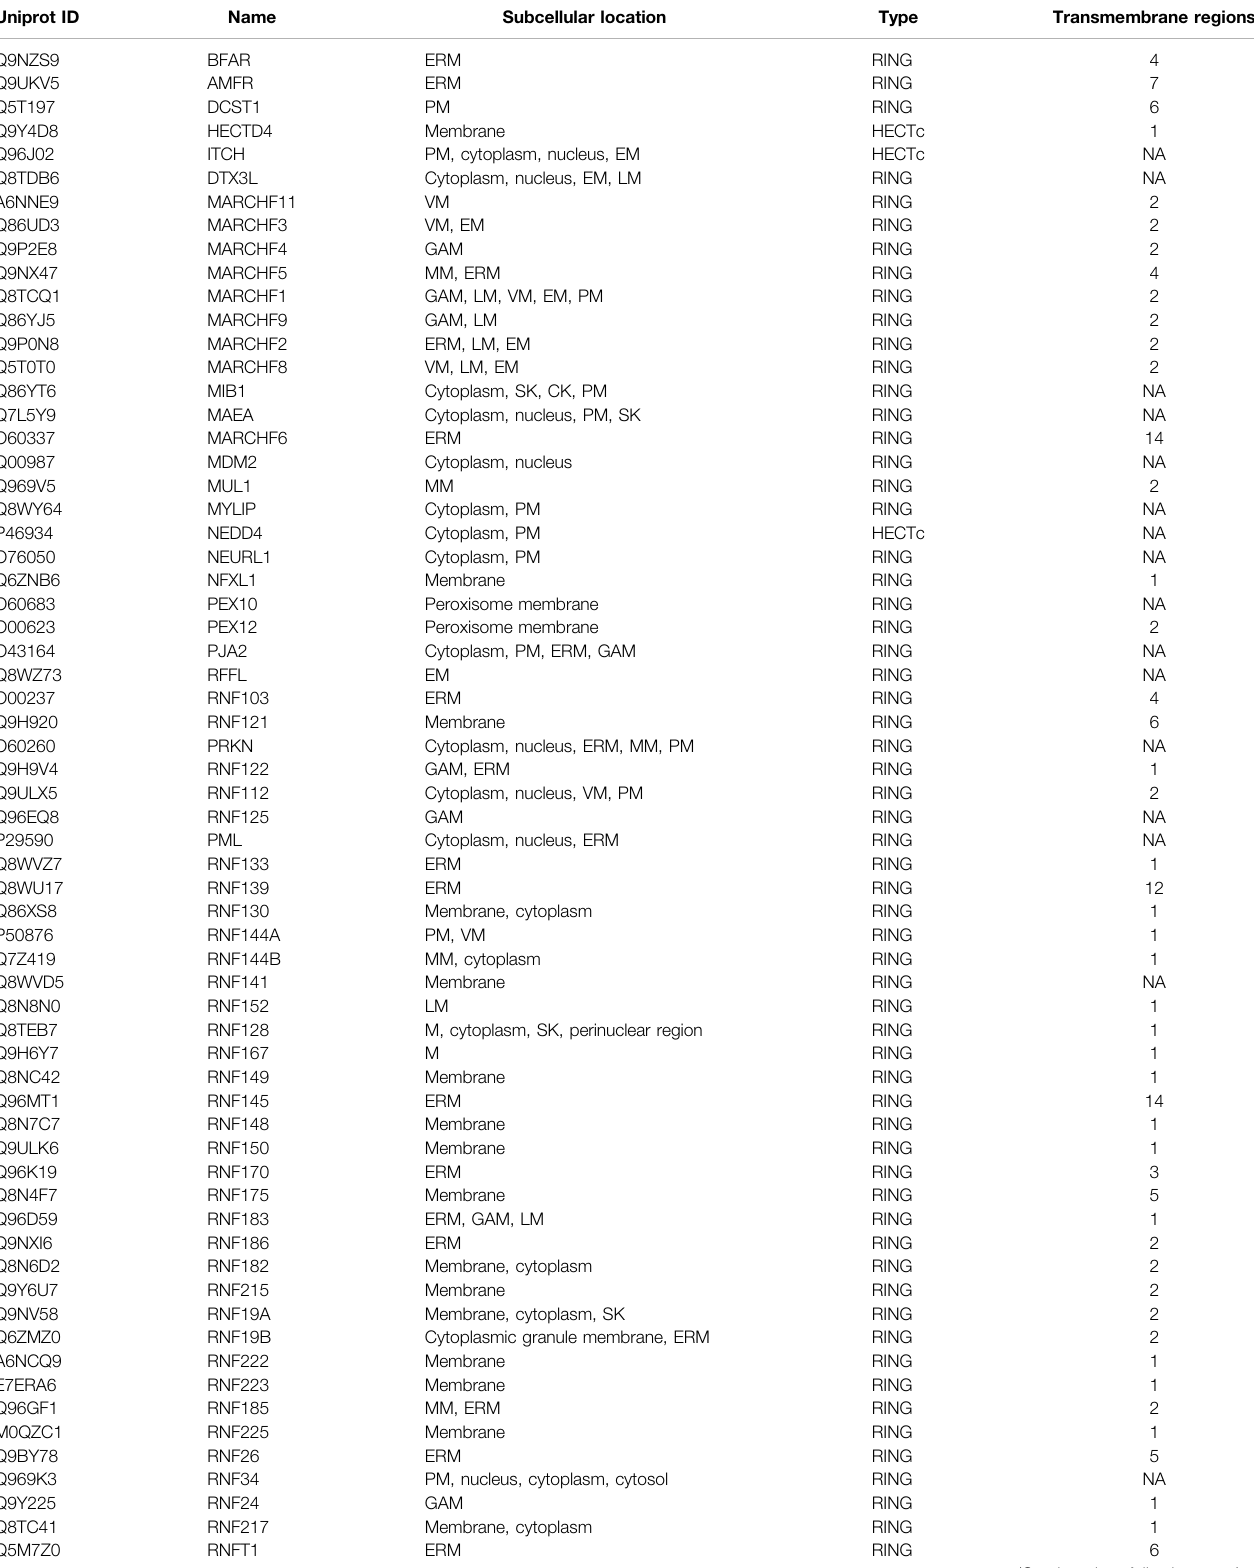
TABLE 1 | 84 membrane-associated E3 ligases. Uniprot